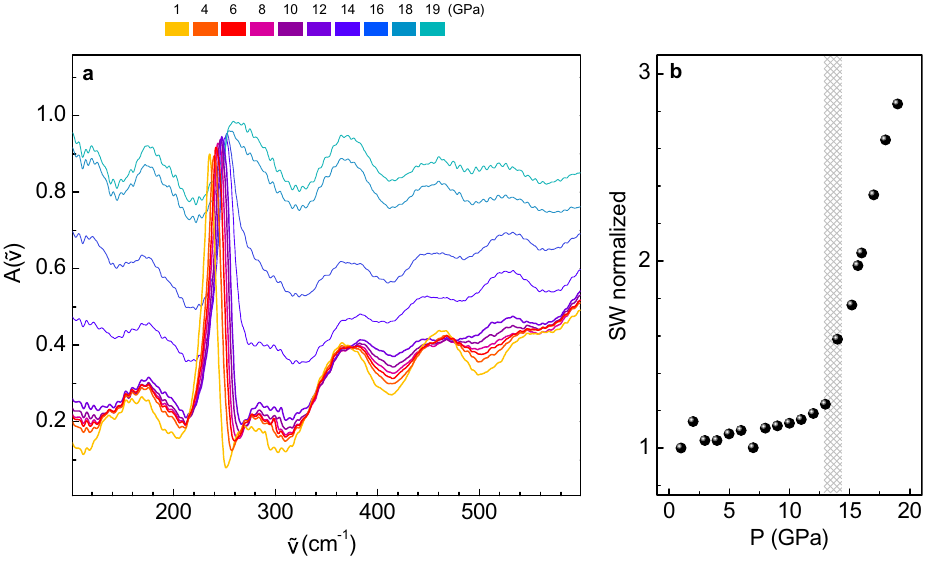
Figure 2. ( a ) Absorbance spectra at selected pressure values over the 1–19 GPa range. ( b ) Normalized spectral weight SW ( P , P 0 ) (see text); the vertical stripe highlights the pressure range where the change of slope